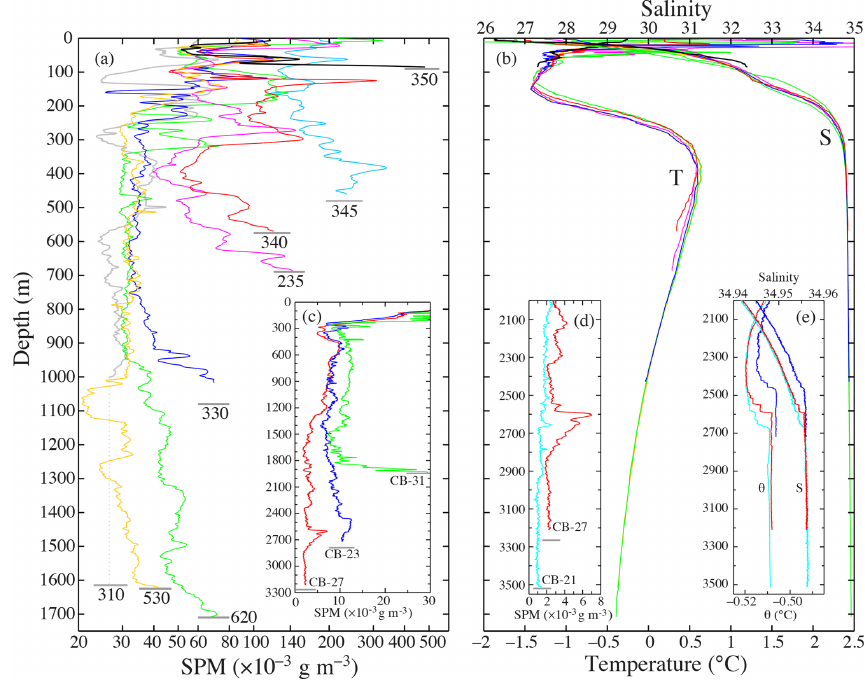
Figure 9. Vertical profiles of (a) suspended particulate matter, SPM, calculated from particulate beam attenuation coefficient at 660nm, c p ( 660 ) , and (b) temperature, T , and salinity, S , at selected “deep” stations. Inserts (c) and (d) show transmissometer data (converted to SPM using Eqs. 1–2) that were collected in the Canada Basin during 21–23 September 2009 and made available by the Beaufort Gyre Exploration Program based at the Woods Hole Oceanographic Institution in collaboration with researchers from Fisheries and Oceans Canada at the Institute of Ocean Sciences. Insert (e) shows a close up of the potential temperature, θ , and S for CB-23, CB-27, and CB-21 at the interface to the Canada Basin Bottom Water layer. Grey horizontal lines indicate bottom depths and are underlain by station numbers (see Fig. 1 for